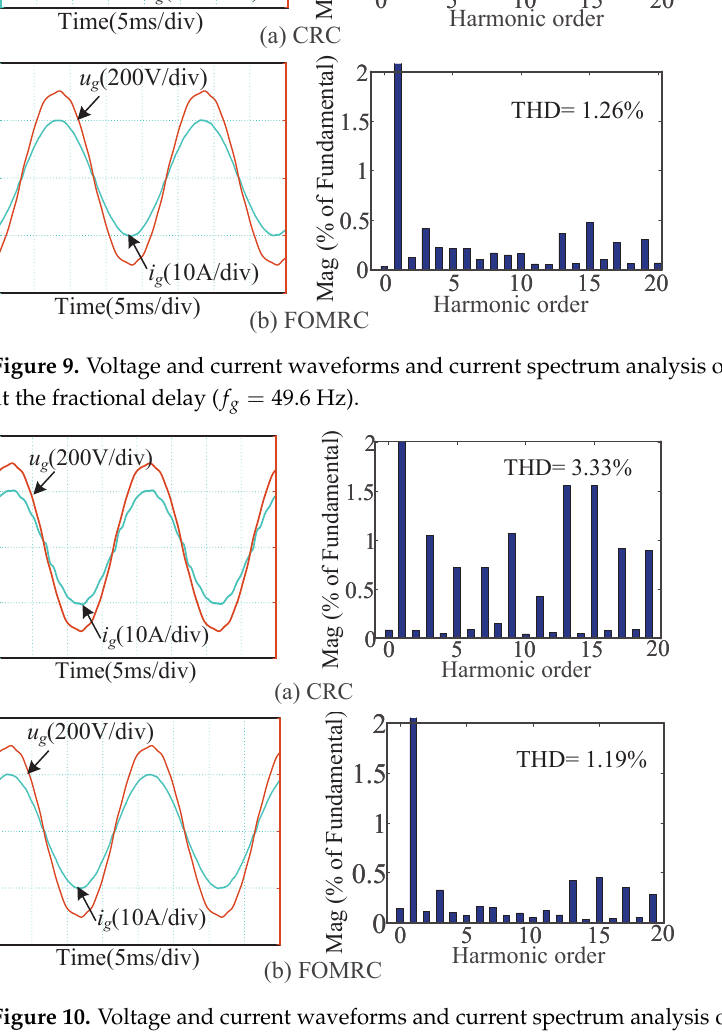
Figure 10. Voltage and current waveforms and current spectrum analysis of the two control systems at the fractional delay ( f g = 50.4